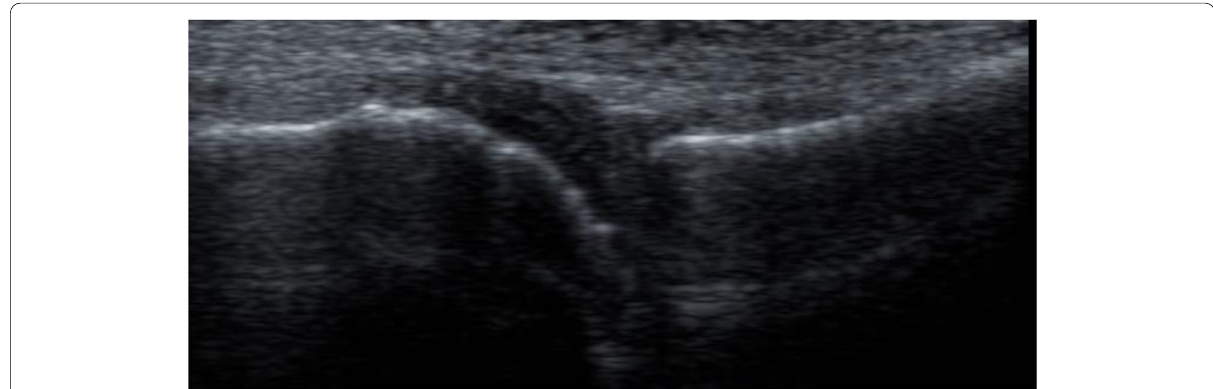
Fig. 3 GSUS dorsal transverse scan showing grade II synovitis in the second MTP joint